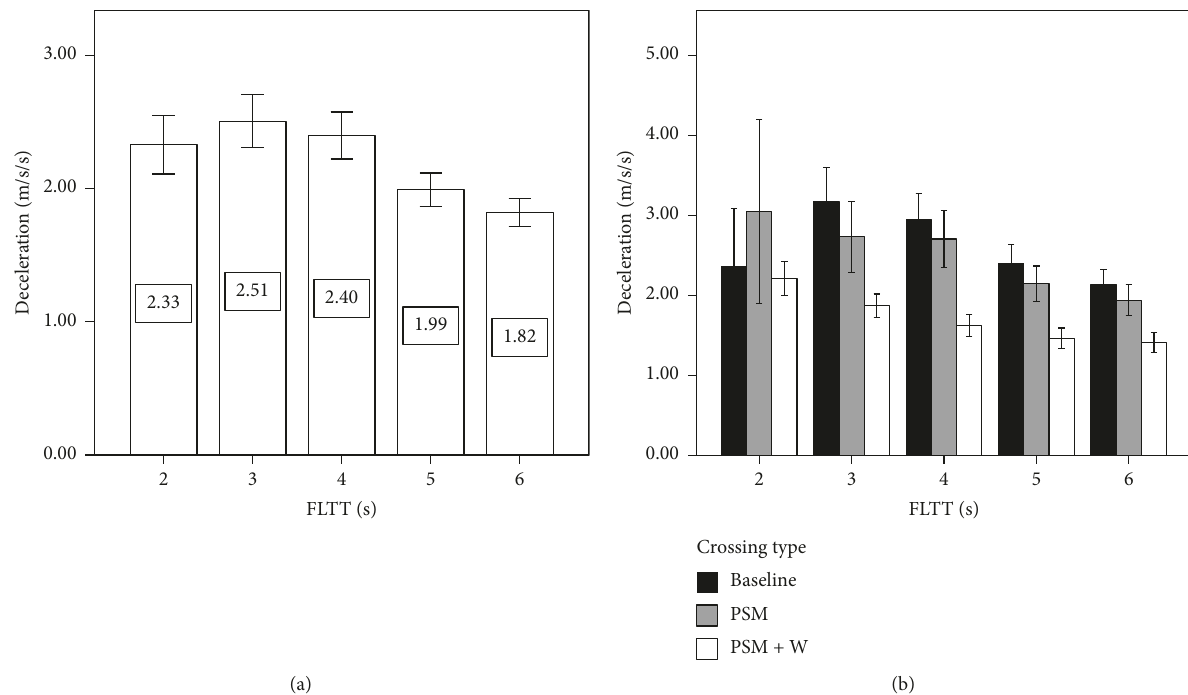
Figure 13: Mean decelerations under different flashing light trigger timing. (a) The main effect of FLTT; (b) the interaction effect between FLTT and crossing